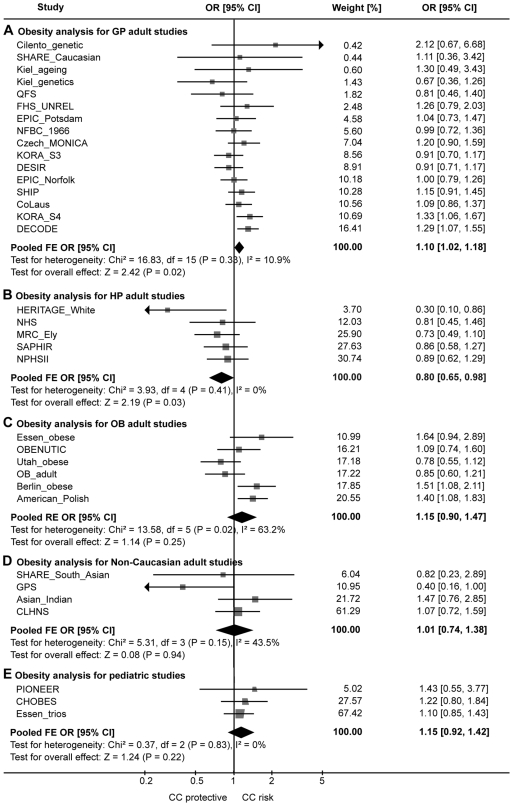
Forest plot on Odds Ratio estimates of the INSIG2 rs7566605 association with obesity.Association with obesity (BMI ≥ 30 kg/m2) for (A) the Caucasian adult general population-based (GP) studies, (B) the Caucasian adult studies ascertained for reasons related to health status (HP), (C) the Caucasian adult obesity case-control studies (OB), (D) the non-Caucasian adult studies, and (E) the pediatric studies. Shown are recessive model OR estimates comparing the CC genotype versus CG or GG for each study and pooled estimates. The fixed effect (FE) model OR is shown in case of no significant heterogeneity as tested by the Q-statistics; a random effect (RE) model is shown otherwise.